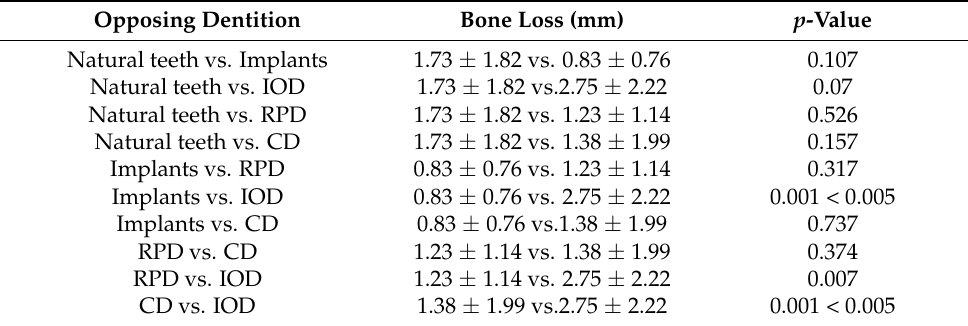
Table 8. p -value and MBL by opposing dentition.